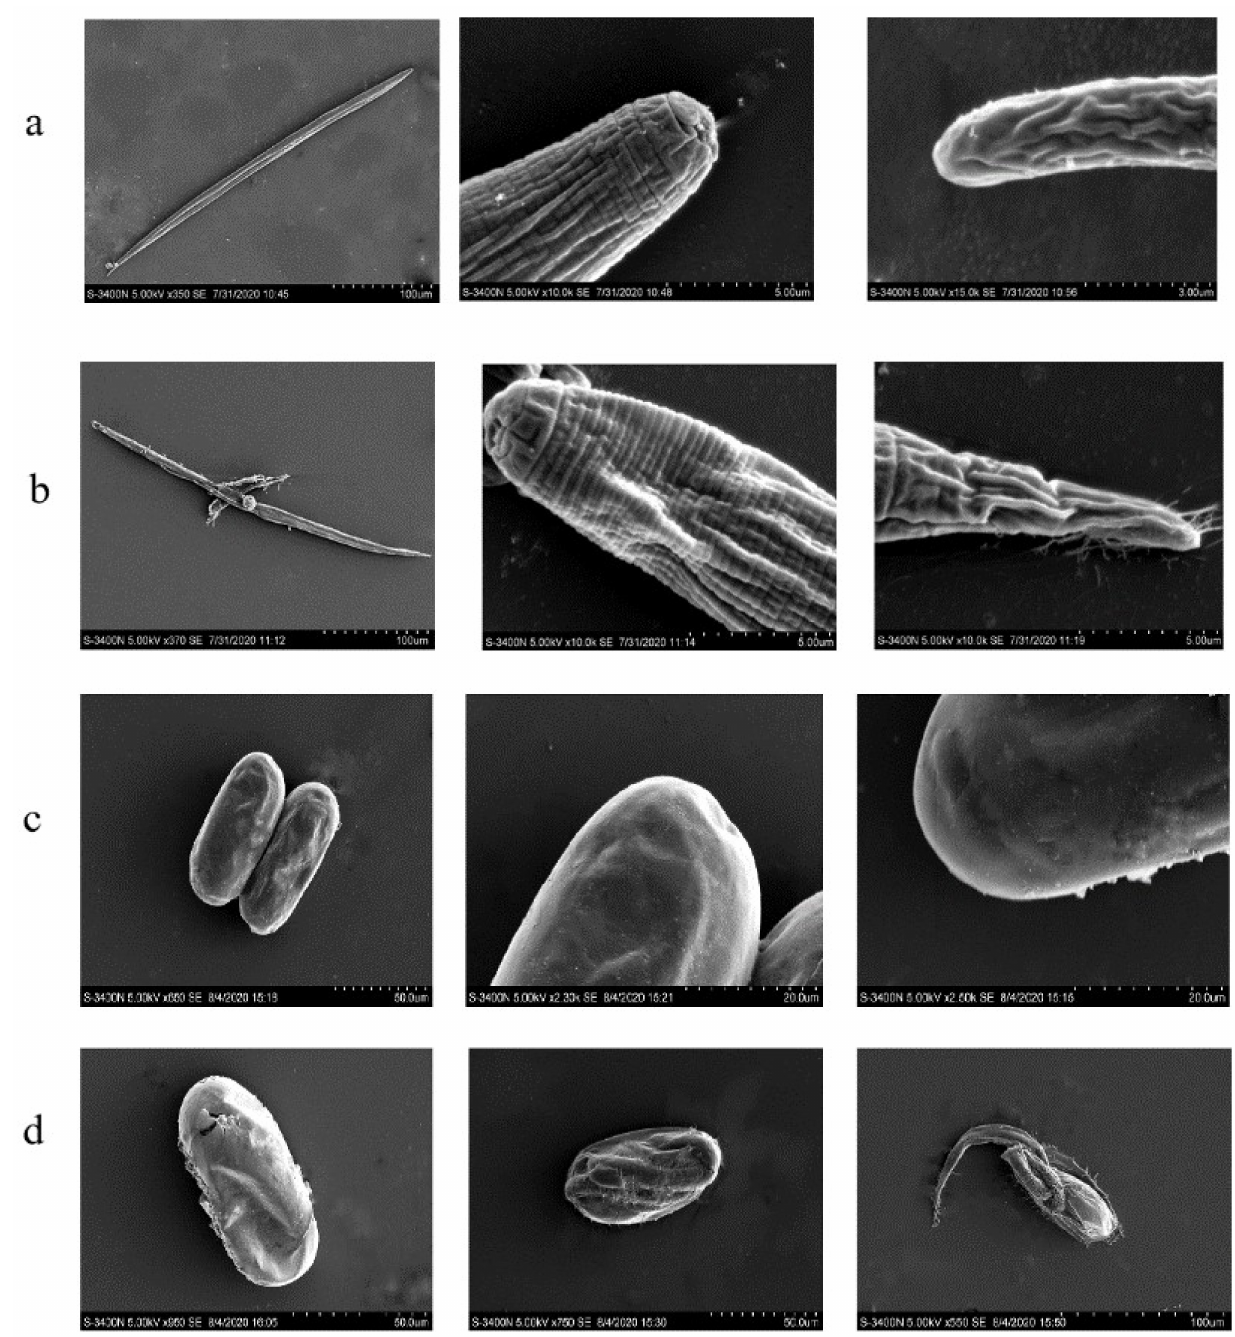
Figure 5. Micrographs of M. incognita treated with OTC-PLF under a scanning electron microscope. ( a , c ) are the M. incognita J2s and eggs in the blank control, respectively. ( b , d ) were M. incognita J2s and eggs treated by OTC-PLF, respectively. OTC-PLF represents the culture filtrates of Purpureocillium lilacinum combined with by